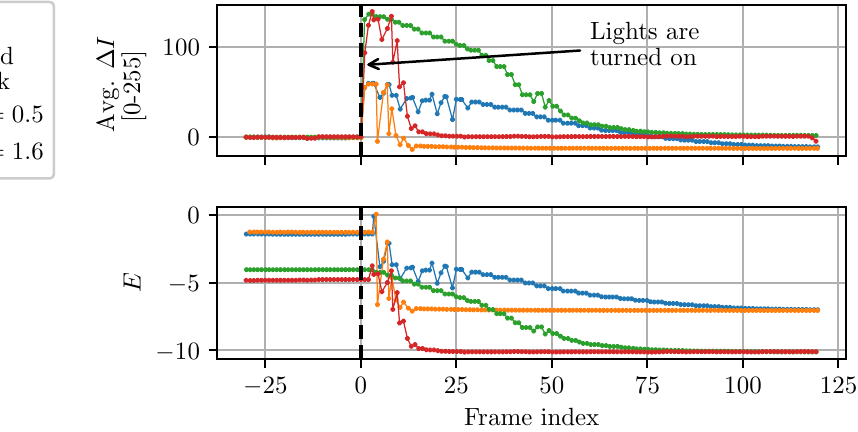
Figure 10. Step response of the proposed AE algorithm subject to an instantaneous increase in ambient light (from ~1 to ~150 lux). Frames are acquired and processed in real time at 60